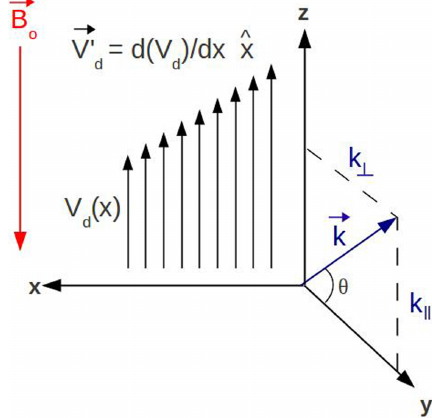
Fig. 1. Geometry of flow shear. The drift velocity is aligned with the magnetic field B ◦ and the gradient in the drift velocity is per- pendicular to B ◦ , in the x-direction. The wave vector k lies in the y-z plane at an angle θ with respect to the direction perpendicular to B ◦ . The perpendicular and parallel components of k are k ⊥ and k k